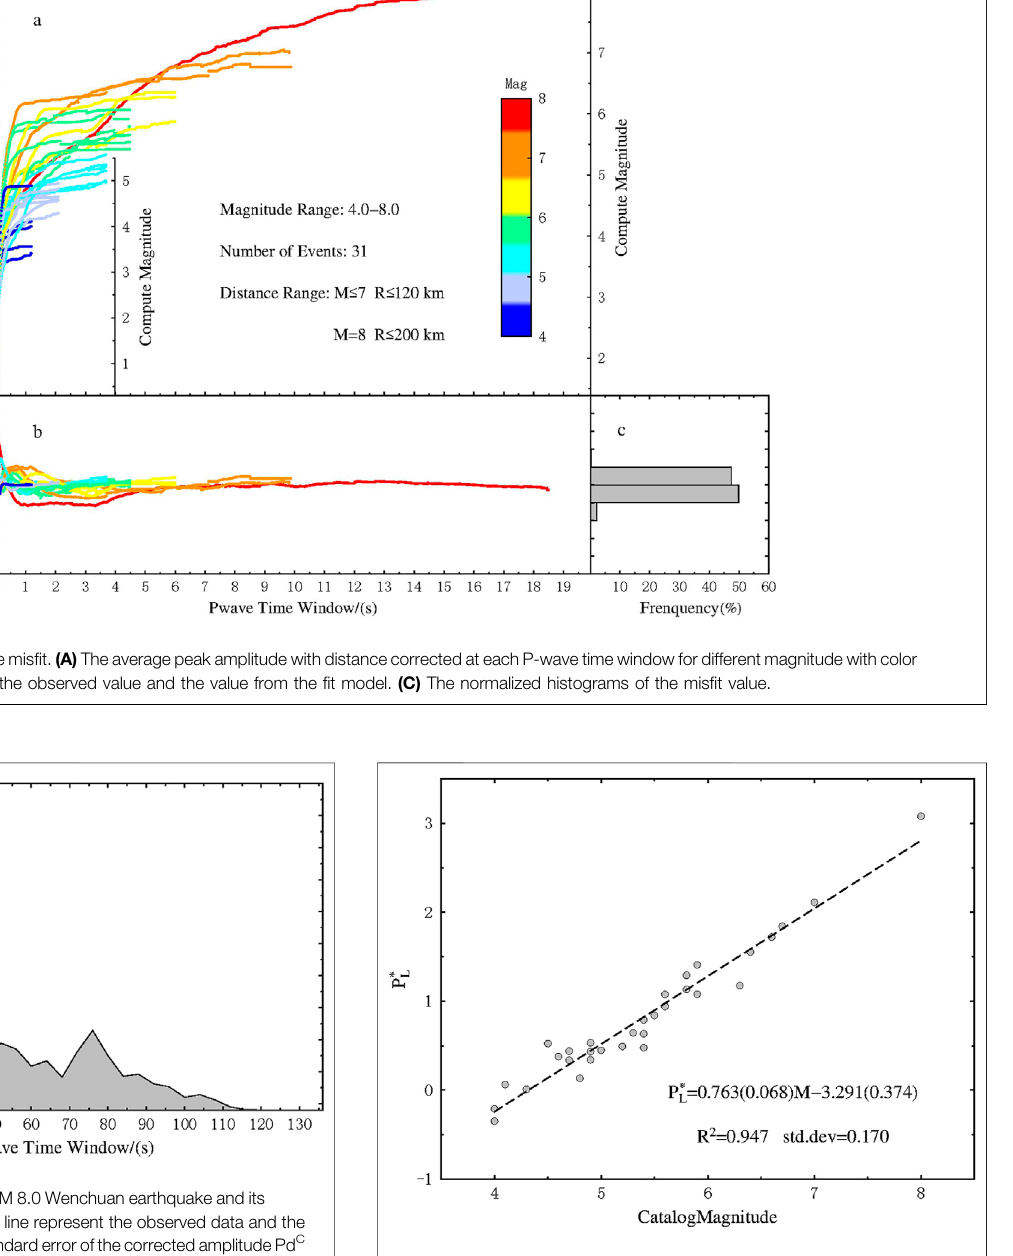
FIGURE5| ScalingrelationshipbetweenP L *andmagnitude.Thecircles present the P L * value of each event. The dashed line indicates the best- fi t relation between P L * and